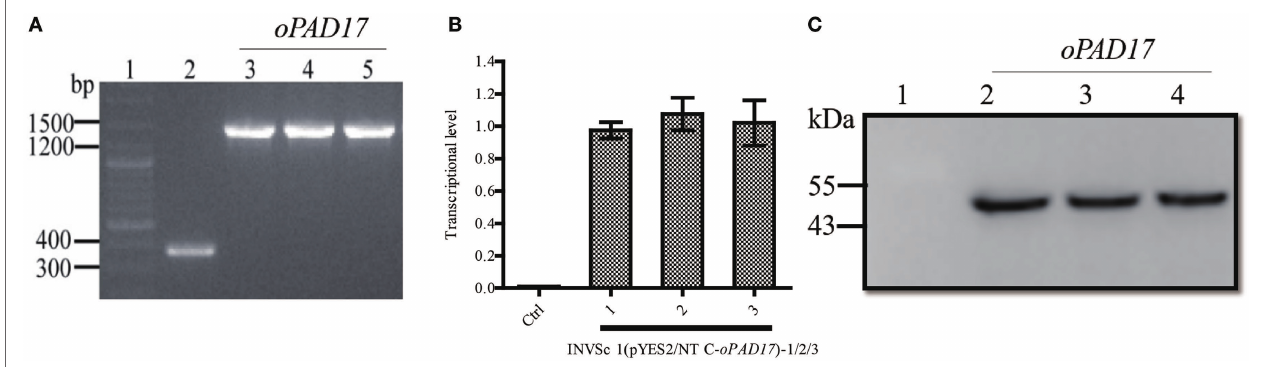
FigUre 2 | Identification of transformants by PCR and analysis of transcription and translation of PaD17 in INVSc 1 (pYES2/NT C- oPAD17 -1/2/3). (a) Map of fragment bands generated by PCR, 1: nucleic acid marker, 2: INVSc1-pYES2/NT C control strains (368 bp), 3–5: INVSc 1 (pYES2/NT C- oPAD17 -1/2/3) (1,448, 1,080 + 368 bp); (B) transcription levels of PaD17; (c) translation levels of PaD17, 1: NVSc1-pYES2/NT C control strains, 2–4: INVSc 1 (pYES2/NT C- oPAD17 -1/2/3) (45